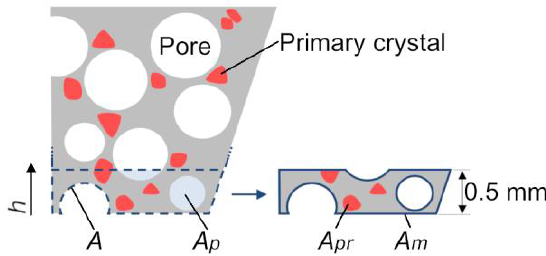
Figure 3. Schematic illustration showing measurement of parameters for pores and primary crystals. A is the area of the measurement window. A p is the area of the pores. A pr is the area of the primary crystals. A m is the area of the metallic parts.